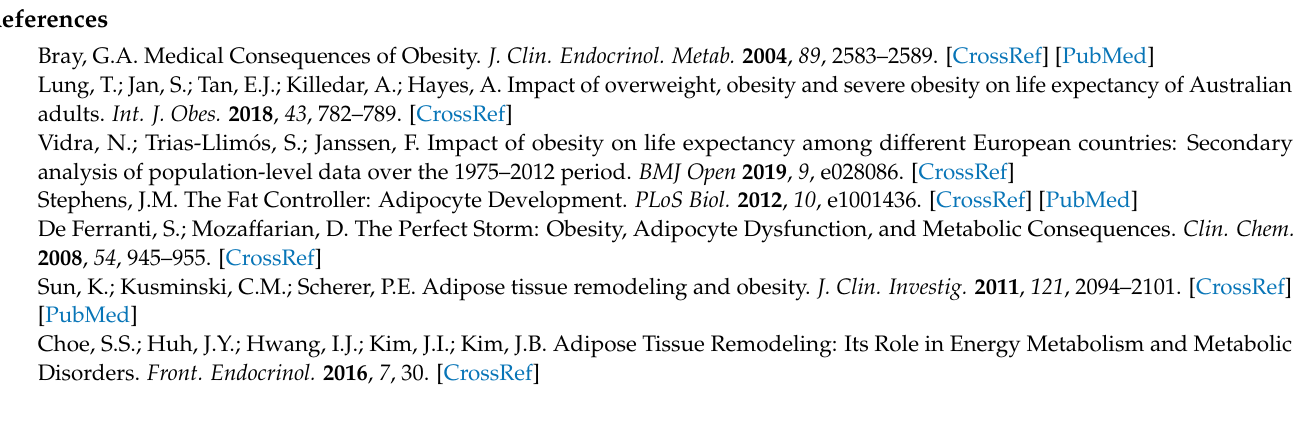
HFD male D; showing the perigonadal white adipose tissue depot, Table S1: Average weight gained, food intake and caloric intake per week by CD females, CD males, HFD females and HFD males, Figure S2: Histology of pancreas harvested from CD female, A; CD males, B; HFD females, C; and HFD males, D. Figure S3: Histology of the thymus harvested from CD females, A and E; CD males, B and F; HFD females, C and G; and HFD males, D and H. Figure S4: Histology of adrenal glands harvested from CD females, A and E; CD males, B and F; HFD females, C and G; and HFD males, D and H. Figure S5: Histology of gastrocnemius muscle (transverse section) harvested from CD females, A; CD males, B; HFD females, C; and HFD males, D. Table S2: Chemokines, anti-inflammatory and pro-inflammatory cytokines measured in the CD and HFD, males and